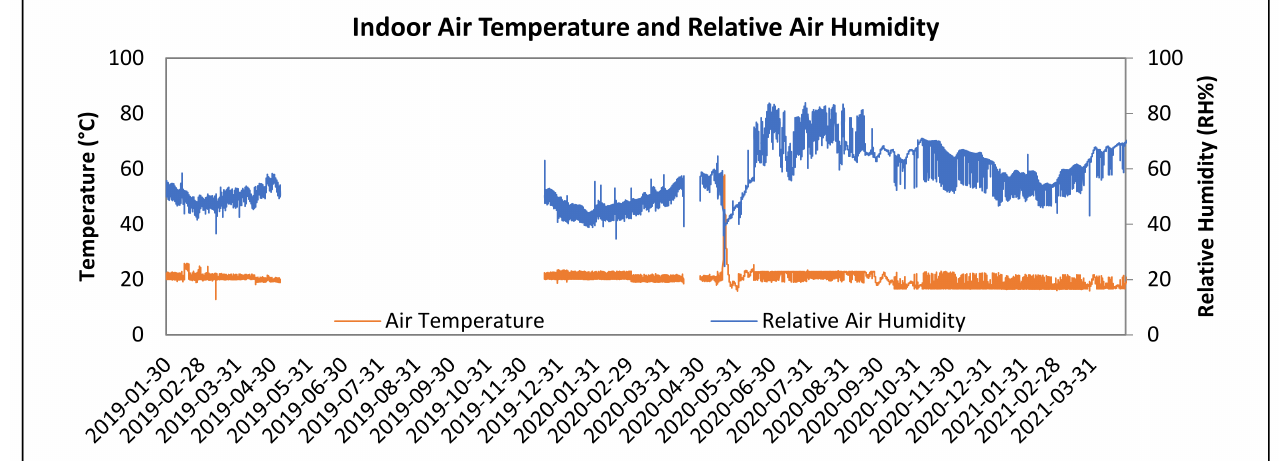
Figure 6. Indoor Air Temperature and Relative Air Humidity during the recorded period.